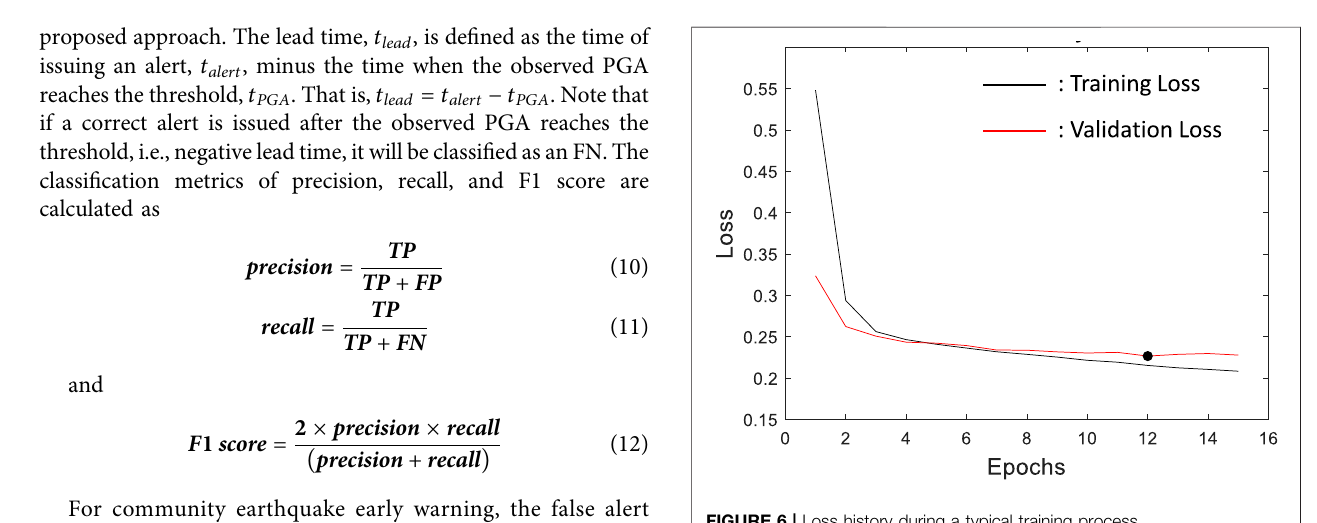
FIGURE 6 | Loss history during a typical training